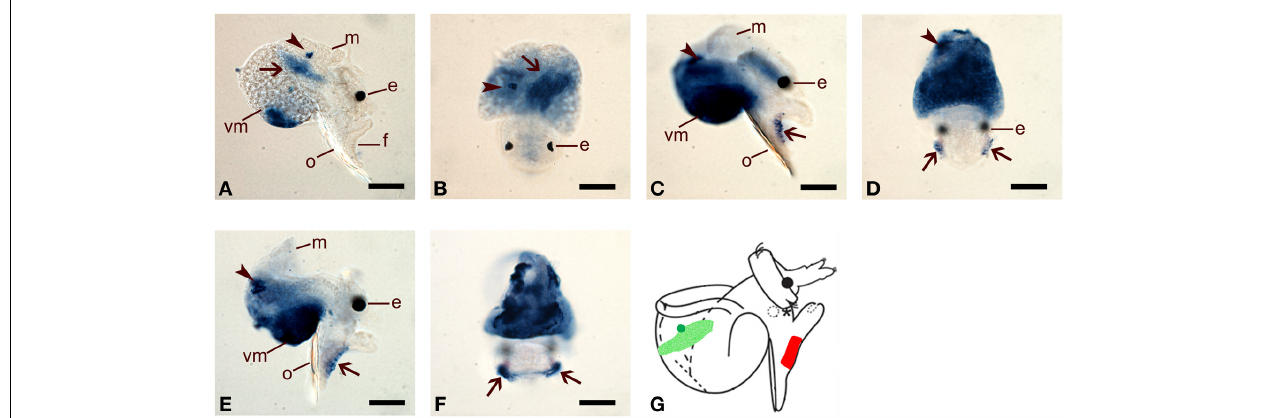
FIGURE 6 | Spatial expression of HasNOS assessed by whole mount in situ hybridisation. Right lateral and dorsal views are shown for each developmental stage. (A,B) 48hpf pre-competent larvae. Probe concentration of 1ng/ μ l was used. Arrows indicate the larval retractor muscle and arrowheads are pointing to a cluster of unidentified cells in the right lateral side of the mantle tissue. (C,D) 72hpf pre-competent larvae. Probe concentration of 2ng/ μ l was used. (E,F) 96hpf competent larvae. Probe concentration of 2ng/ μ l was used. In (C–F) , arrows indicate the cells aligned along the bottom of the lateral edge of the foot and